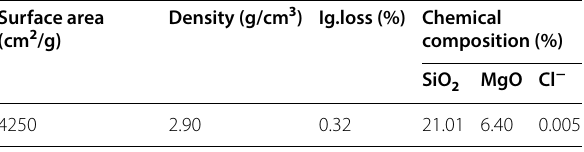
Table 3 Chemical compositions and physical properties of GBFS.